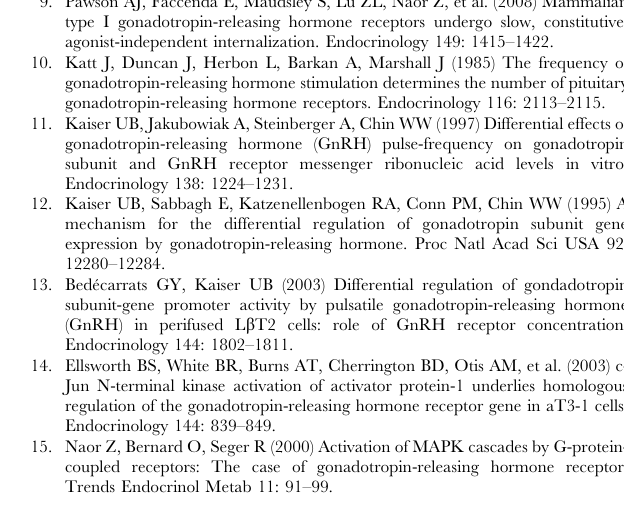
Figure S3 Sensitivity analysis of the expanded model with receptor dynamics to k1. The expanded model with receptor dynamics was simulated for 1440 min. Thereafter k1 was varied by 10% to visualize the effects of such fluctations to the overall frequency-decoding ability of the system. Fold-differences of the accumulated concentrations for each subunit gene were then plotted. PDF) Figure S4 Sensitivity analysis of the expanded model with receptor dynamics to k11. The expanded model with receptor dynamics was simulated for 1440 min. Thereafter k11 was varied by 10% to visualize the effects of such fluctations to the overall frequency decoding ability of the system. Fold-differences of the accumulated concentrations for each subunit-gene were then plotted. PDF) Figure S5 Sensitivity analysis of the expanded model with receptor dynamics to kinetic constants other than k1 and k11. The expanded model with receptor dynamics was simulated for 1440 min. Thereafter, each kinetic constant other than k1, k11 and those already tested, was varied by 10%, in turn, to visualize the effects of such fluctations to the overall frequency-decoding ability of the system. Fold-differences of the accumulated concentrations for each subunit-gene were then plotted. Only results for the kinetic constant, k3, have been shown here. Found at: doi:10.1371/journal.pone.0007244.s009 (0.16 MB PDF) File S1 Supplementary information for methods and